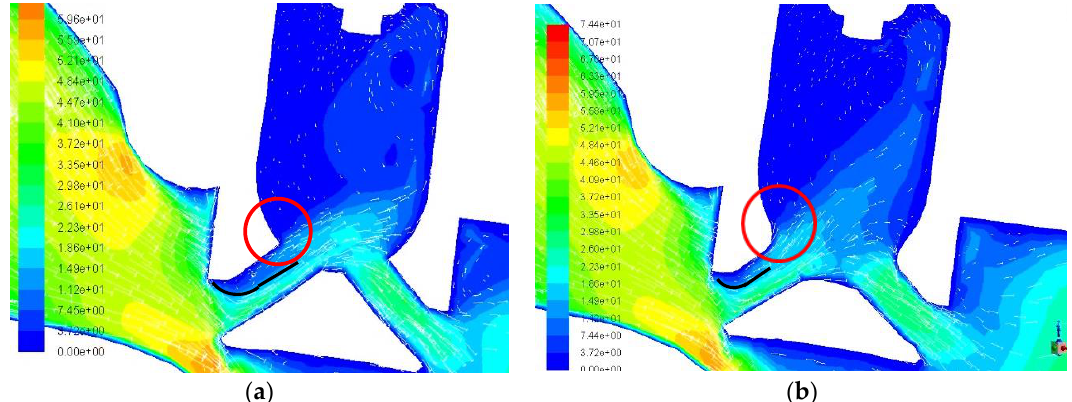
Figure 6. The contour of velocity magnitudes around the prechamber during the inlet stroke at the 64.1° form the degree from the top dead center (TDC). ( a ) The sharp inner edge (red circled area) of inlet and outlet ducts. ( b ) The chamfered inner edge (red circled area) of inlet and outlet ducts.